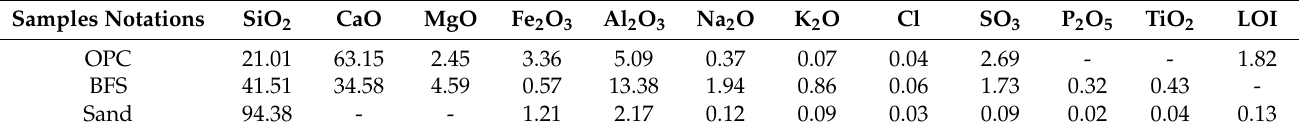
Table 1. Chemical oxides compositions (determined by X-ray fluorescence) of the starting raw materials wt.%.